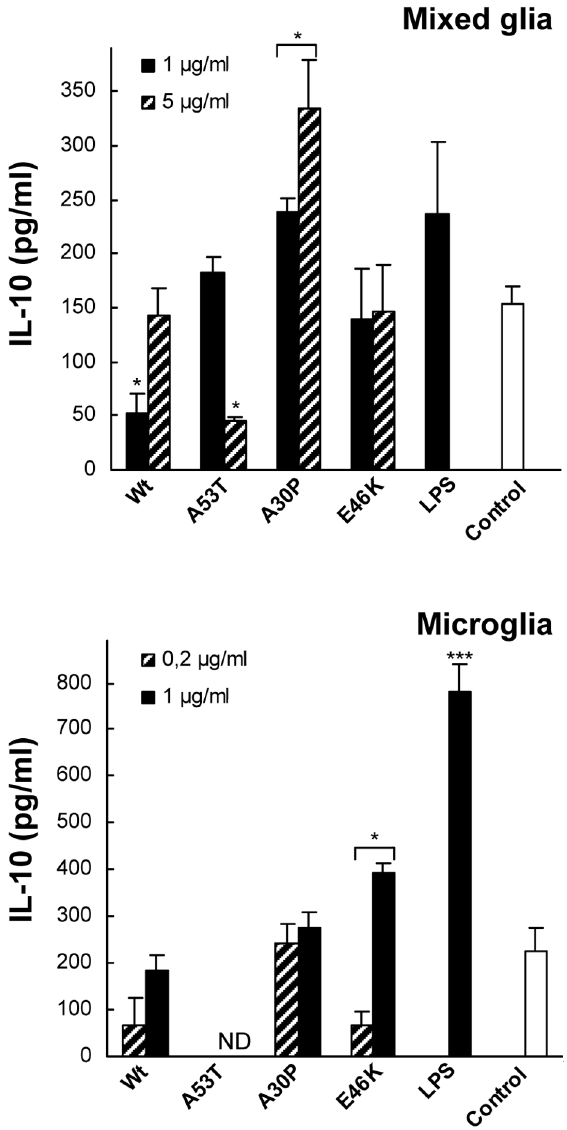
Figure 4. Immunoregulatory effect of a -Syn-stimulation in primary mixed glial and isolated microglial cultures. IL-10 release was measured by ELISA in supernatants of a -Syn-stimulated mixed-glial cultures (top) and microglia (bottom) after a 20-hour treatment with monomeric Wt or mutant a -Syn variants, or lipopoly- saccharide (LPS). Values are mean 6 S.E.M. (n=4). * P , 0.05, ** P , 0.01, *** P , 0.001. The results shown are representative of two or three independent experiments with microglia and mixed glial cultures, respectively.